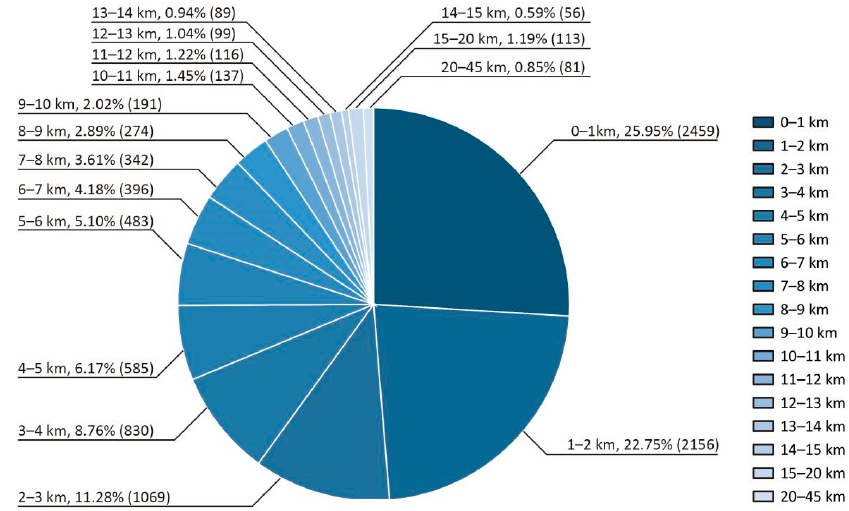
Figure 7. Number and proportion of employees living in the Corridor with different commuting distances.